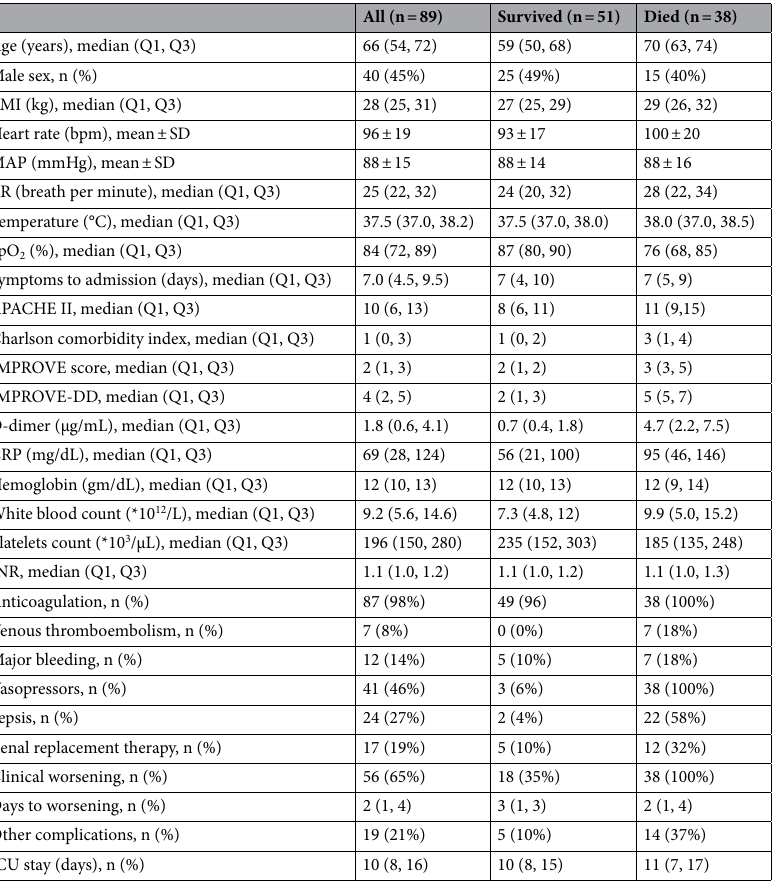
Table 1. Demographic data, clinical data, and ICU course. APACHE II acute physiology and chronic health evaluation II, BMI body mass index, CI confidence interval, CRP C-reactive protein, DD D-dimer, ICU intensive care unit, IMPROVE international medical prevention registry on venous thromboembolism, INR international normalized ratio, MAP mean arterial pressure, RR respiratory rate, SD standard deviation, SpO 2 peripheral oxygen saturation, Q